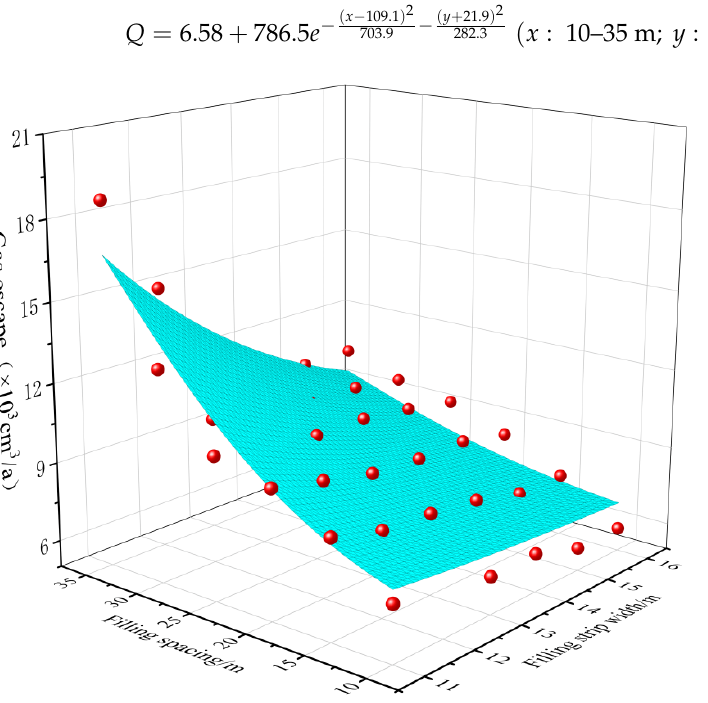
Figure 13. Fitting surfaces of different filling spacings and strip filling widths with the gas escape amount.